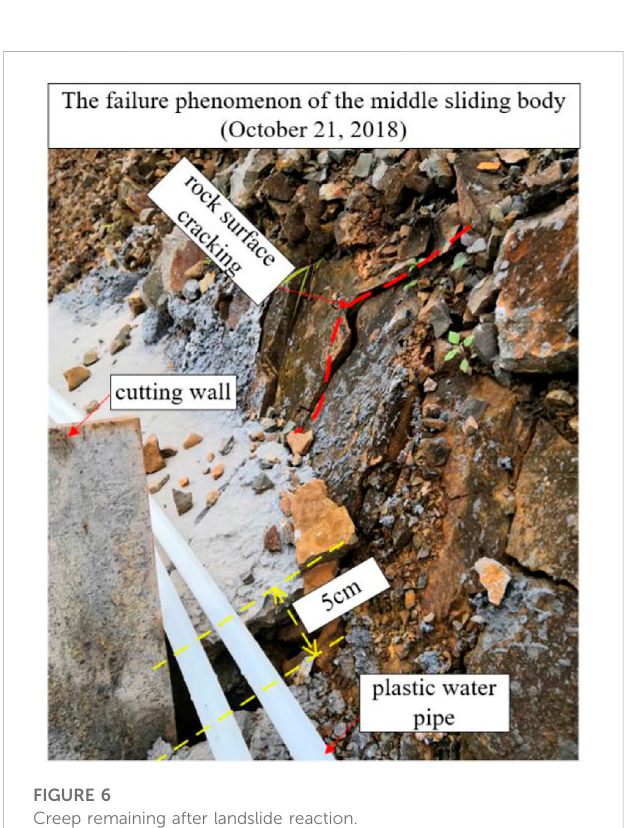
FIGURE 6 Creep remaining after landslide reaction.